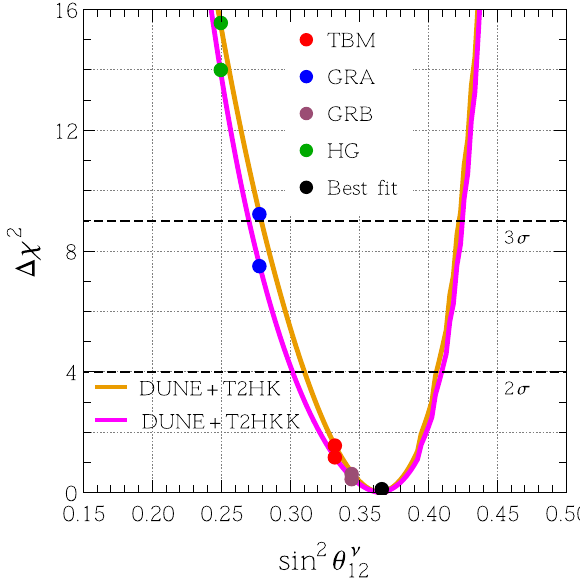
Fig. 1 Status of the lepton mixing symmetry forms in light of the current best fit values of the mixing angles and the CPV phase δ CP and using the potential of DUNE + T2HK and DUNE + T2HKK. The = 0 . 364obtainedfromEq.(1.1)using blackdotcorrespondstosin 2 θ ν 12 the present best fit values of θ 12 , θ 13 , θ 23 , and δ CP . The coloured dots correspond to the values of sin 2 θ ν for the TBM, GRA, GRB, and HG 12 symmetry